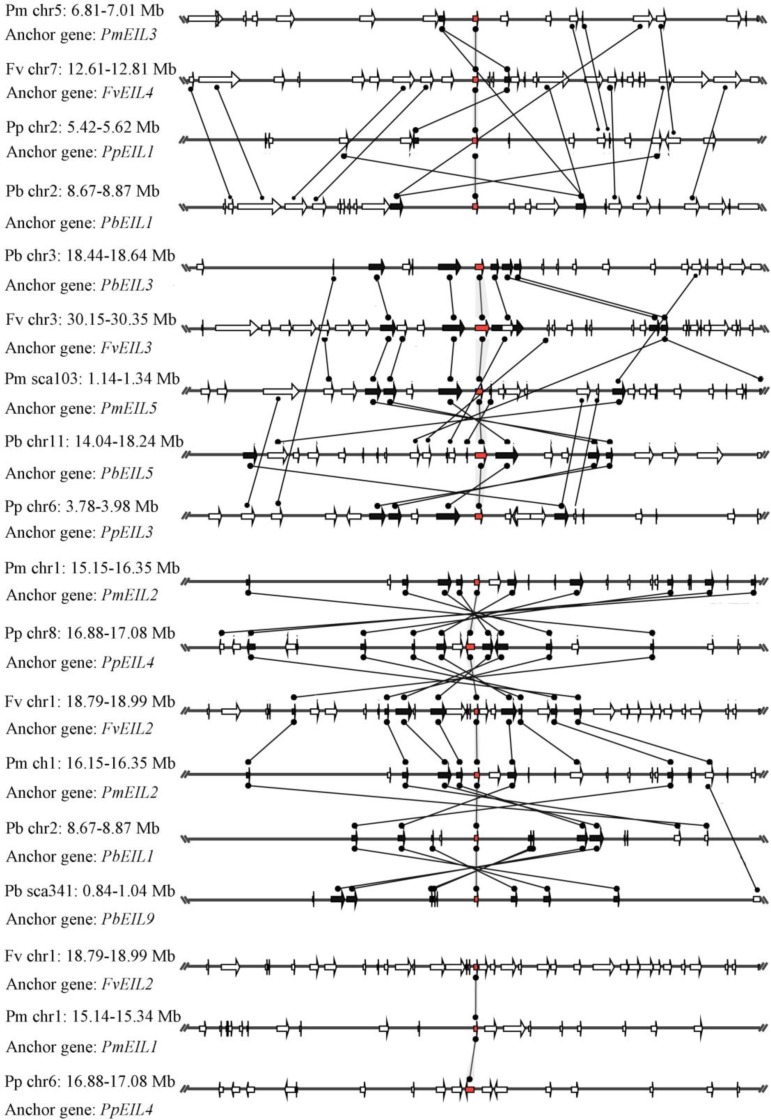
Interspecies microsynteny related to EIN3/EIL families in four Rosaceae.The relative positions of all flanking protein-coding genes were defined by anchored EIN3/EIL genes, highlighted in red. The gene’s orientations are shown as triangle, with gray lines corresponding to chromosomal segments.